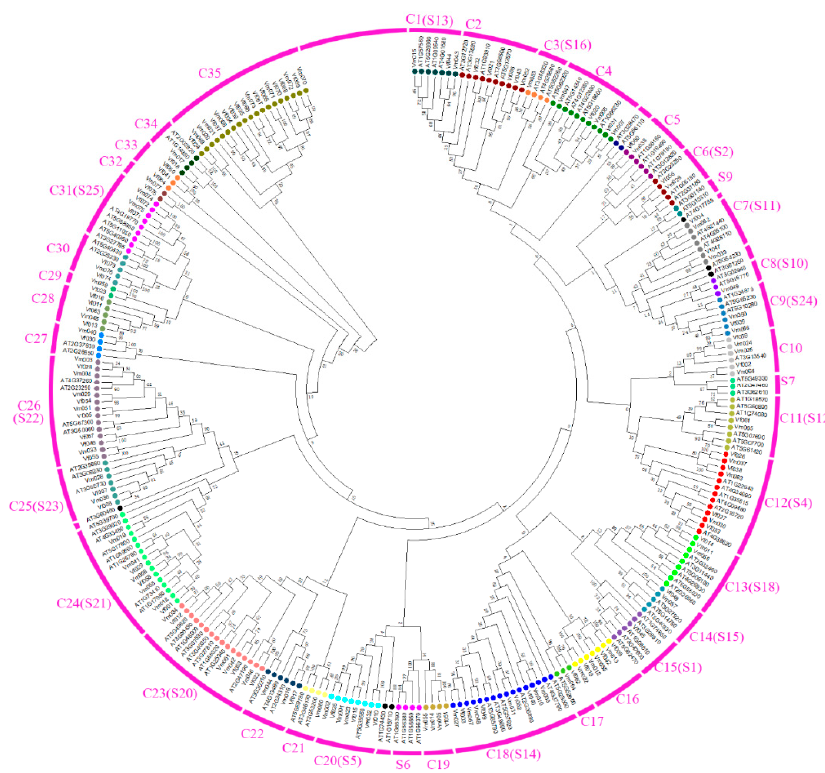
Figure 2. Phylogenetic relationships of MYB family proteins in Arabidopsis , V. fordii and V. montana . 278 MYB proteins from Arabidopsis , V. fordii and V. montana were used to do the multiple sequence alignment and construct the unrooted phylogenetic tree. BioEdit 5.0.6 with the default settings and MEGA 7.0.7 with the UPGMA method and 1000 bootstrap replications were used. Different colored dots represent different subgroups.